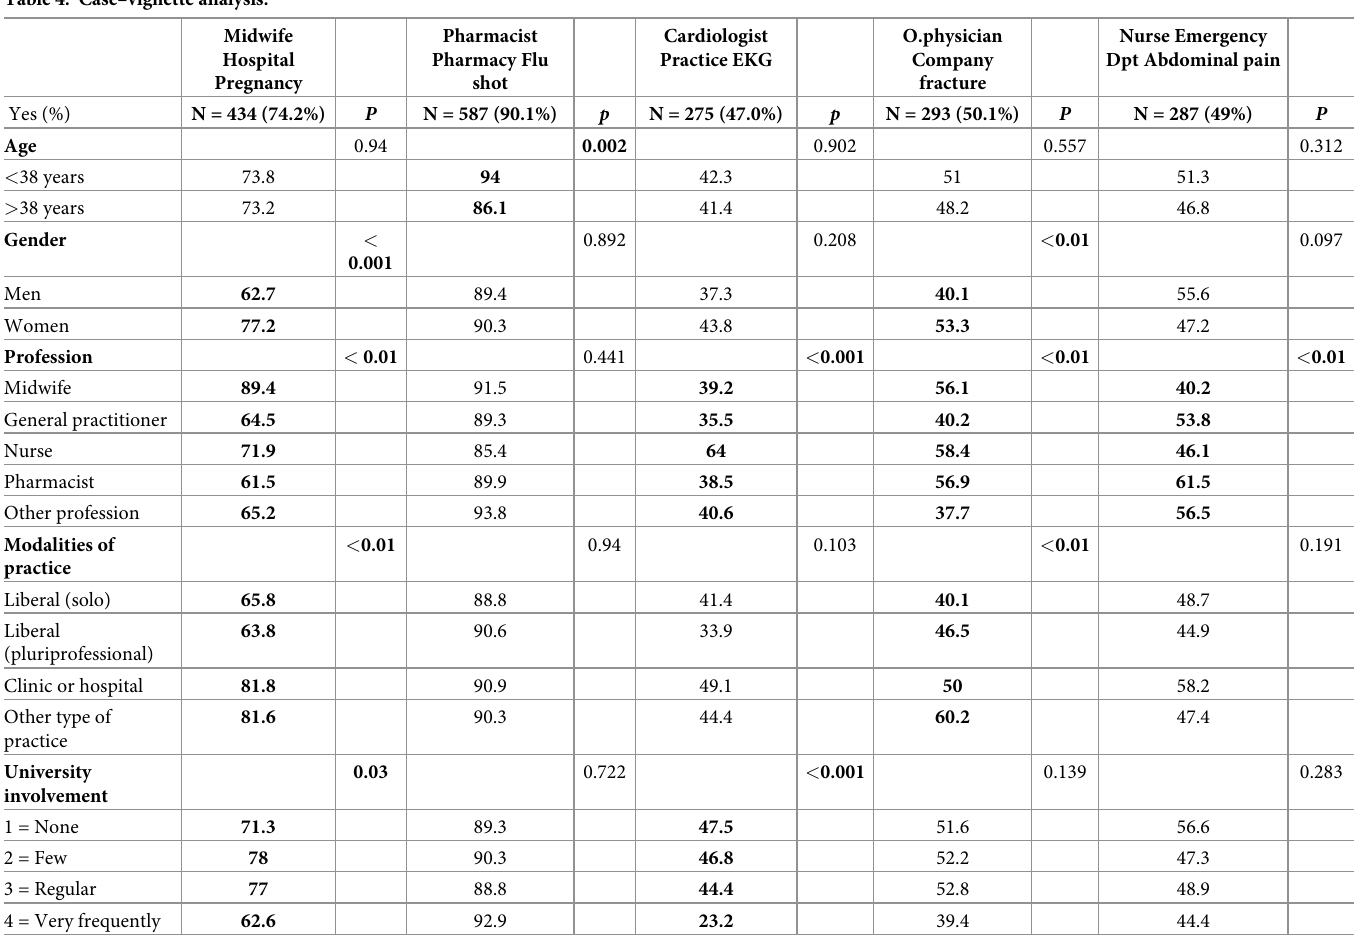
Table 4. Case–vignette